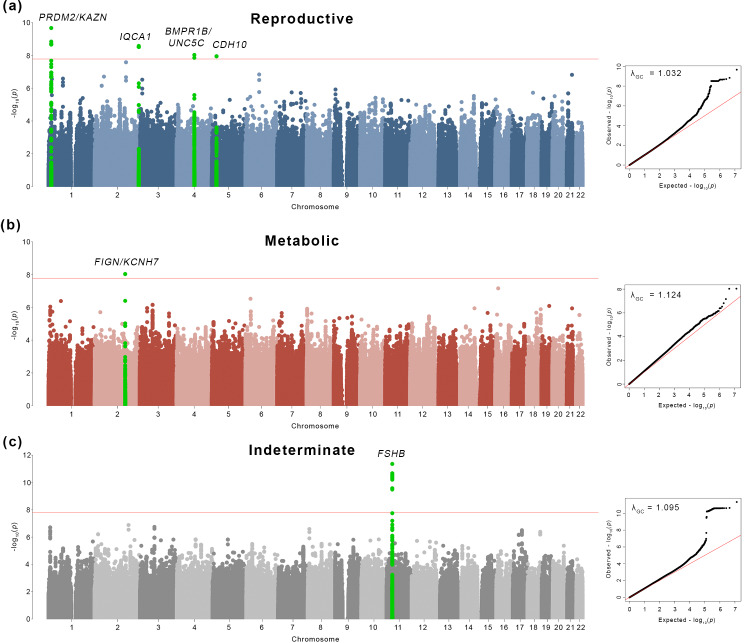
Genome-wide association results.Manhattan plots for (a) reproductive, (b) metabolic, and (c) indeterminate PCOS subtypes. The red horizontal line indicates genome-wide significance (P ≤ 1.67 × 10−8). Genome-wide significant loci are colored in green and labeled according to nearby gene(s). Quantile–quantile plots with genomic inflation factor, λGC, are shown adjacent to corresponding Manhattan plots. PCOS, polycystic ovary syndrome.